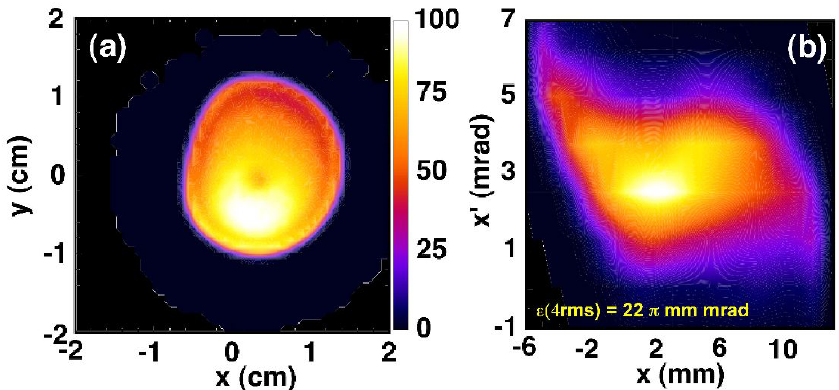
FIG. 15. (Color) (a) Transverse beam distribution calculated 56 cm downstream of the exit of two solenoids at the scintillator plane ( z (cid:6) 187 cm ); (b) sheared phase-space distribution calculated 40 cm downstream of the exit of two solenoids at the scintillator plane ( z (cid:6) 171 cm ). All were calculated using the recessed emitter, misaligned solenoids, and nonlinear focusing